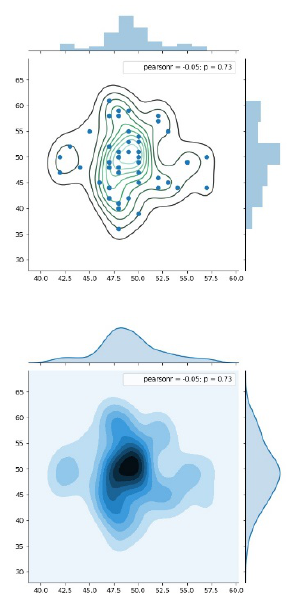
Figure 1. Data generation process schema In the process of generating a pair of data randomly, two multi-dimensional arrays will generate 100 discrete points on the basis of matching characteristics. The data coupling is realized by KDE mode for the next experiment. One of the final data arrays has four gradient variances, resulting in 800 image data to simulate data with four different